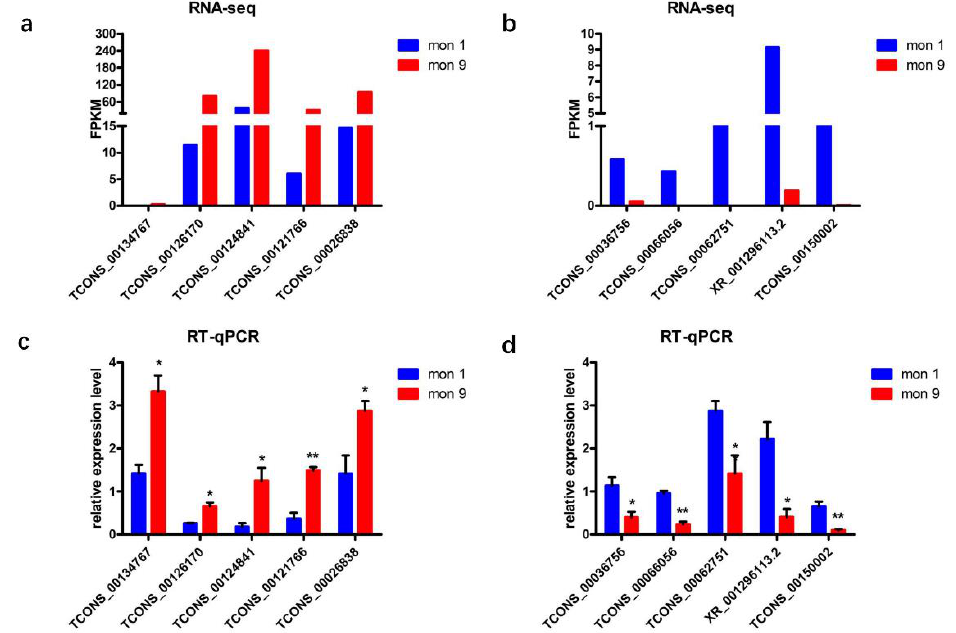
Figure 6. RT-qPCR validation of DE lncRNAs. The expression levels of lncRNAs downregulated in 1-month-old stage by RNA-seq ( a ) and RT-qPCR ( c ). The expression levels of lncRNAs upregulated in 1-month-old stage by RNA seq ( b ) and RT-qPCR ( d ). Data represent mean ± SE. * p < 0.05 and ** p < 0.01.